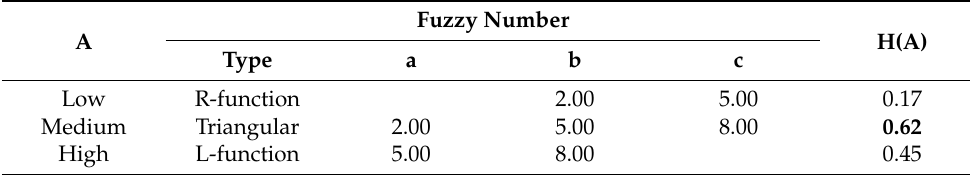
Figure 7. The initial fuzzy partition given by 3 fuzzy numbers. Table 4. Fuzzy sets in the fuzzy partition in Figure 7 and their